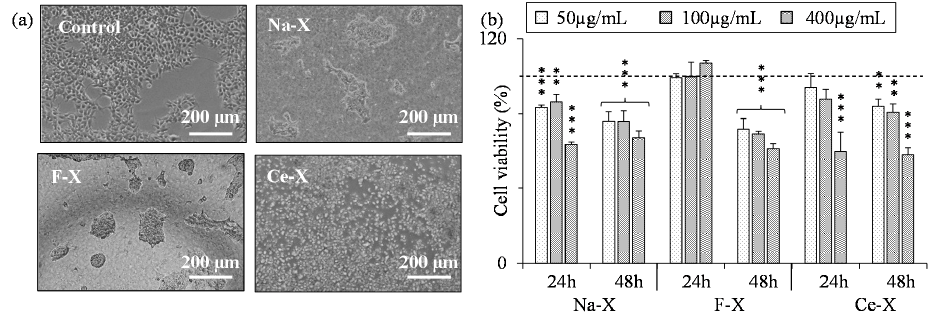
Figure 8. ( a ) Representative photographs (phase contrast) of U87-MG cells after 48 h exposure to 400 µg/mL of as-synthesized Na-X, fluorinated F-X, cerium ion exchanged Ce-X zeolites, and a control sample (H 2 O); ( b ) Quantification of U87-MG cells viability after 24 h and 48 h exposure to Na-X, F-X, and Ce-X zeolites with different concentrations. Cell viability was assessed using the WST-1 test. Mean ± SD. n = 3; HSD Tuckey post-hoc test after a significant ANOVA (** p < 0.005 vs. control group).